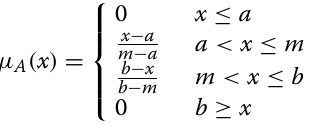
Generated Channel state sample description